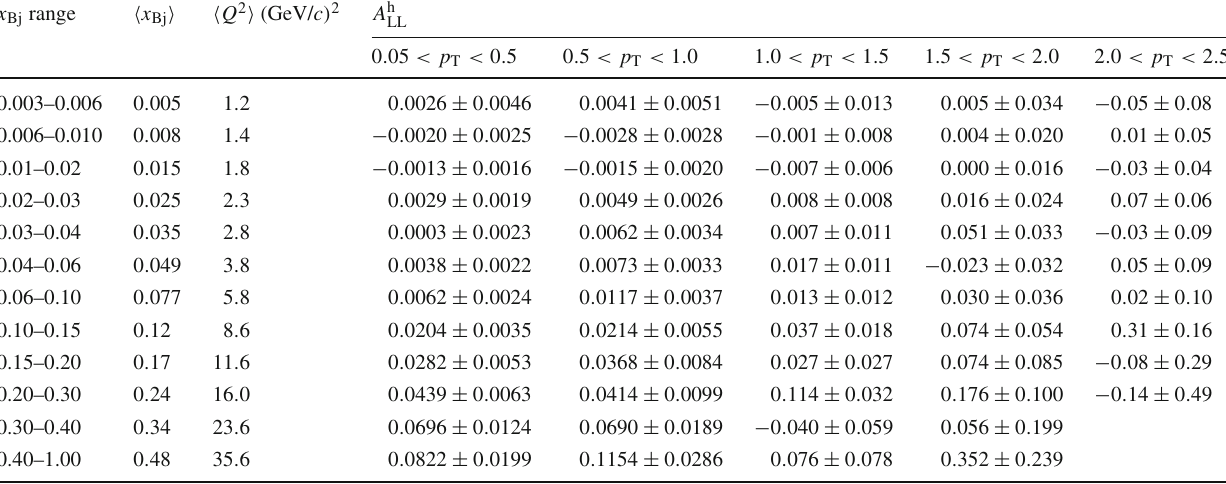
in bins of x Bj and of p T given in (GeV/ c ). LL